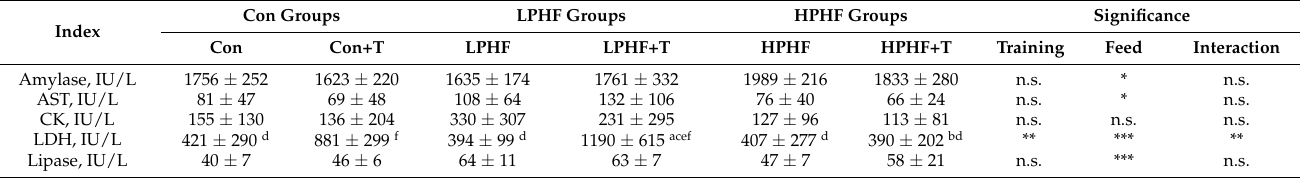
Table 4. Effects of LPHF, HPHF, and/or training on plasma muscle/organ damage indicators.